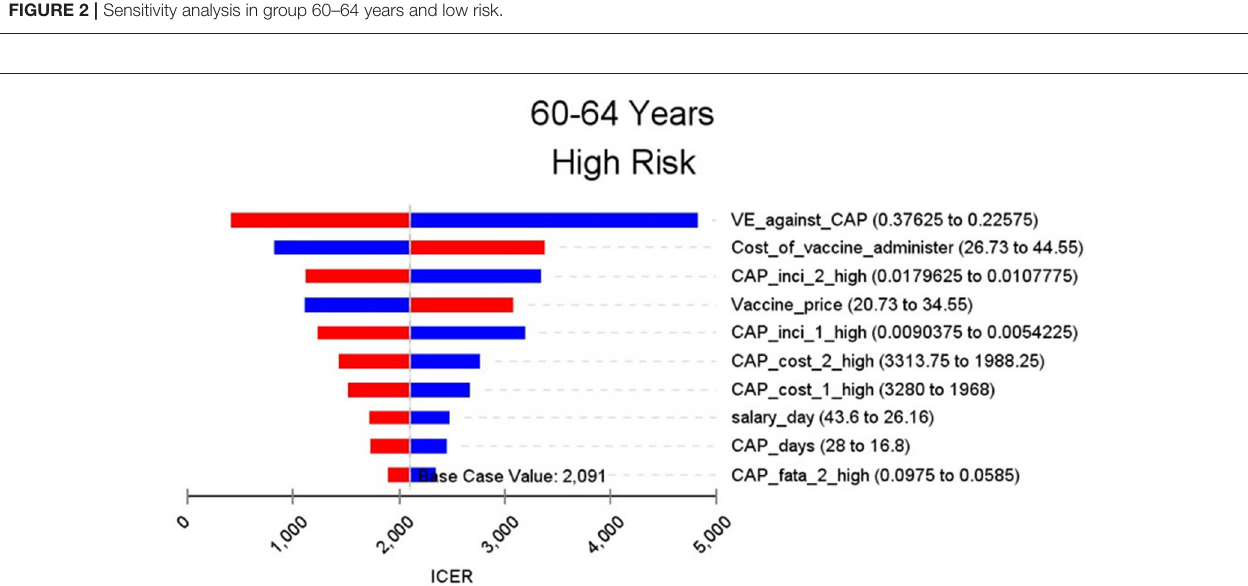
FIGURE 3 | Sensitivity analysis in group 60–64 years and high